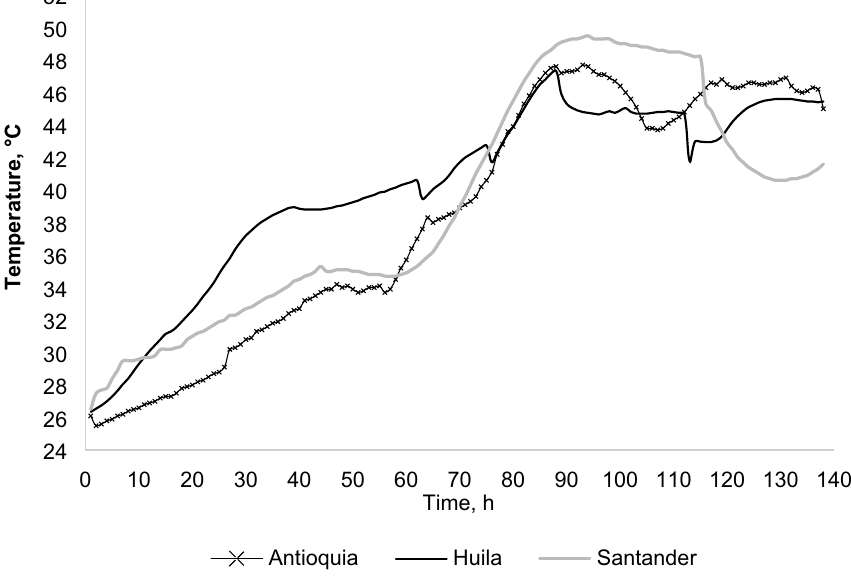
Figure 1. Temperature profile in the fermenter at the respective locations in the departments of Antioquia, Huila, and